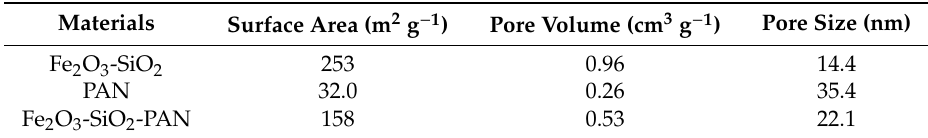
Figure 5. SEM-EDX mapping on Fe 2 O 3 -SiO 2 -PAN.